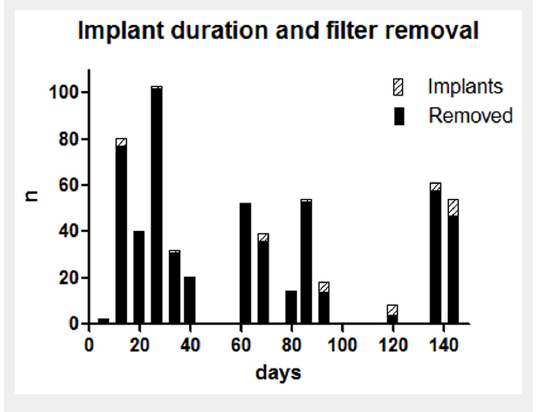
Proportion of filters removed over time. It is interesting to note, that up to 84 days, 100% filter removal can be obtained by conventional means (hooks and